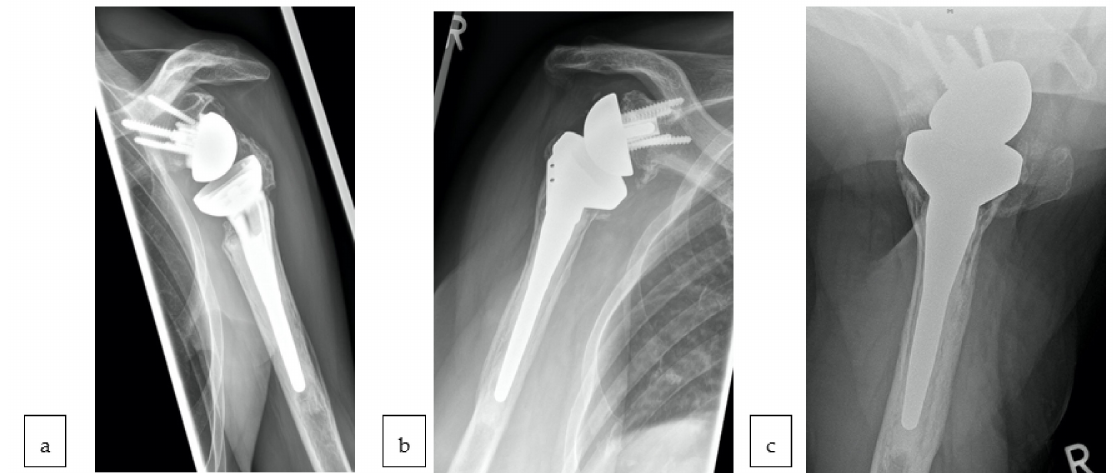
Figure 3. Tuberosity evaluation: A 76-year-old female patient treated with the fracture specific stem shows malunion of greater tuberosity (GT) and resorption of lesser tuberosity (LT) ( a ). A 68-year-old female patient with standard stem shows anatomical healing of LT and malunion of GT in true a/p ( b ) and axial ( c )